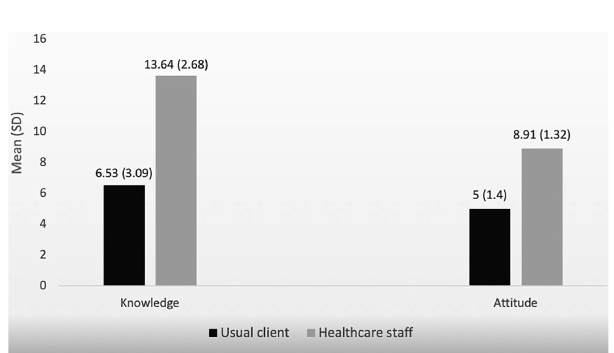
attitude scores in study